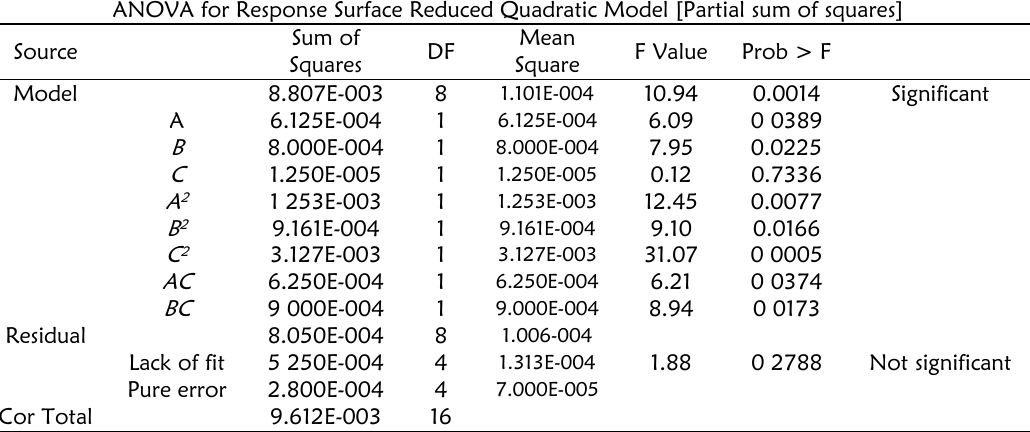
Table 4: Reduced ANOVA for Response R